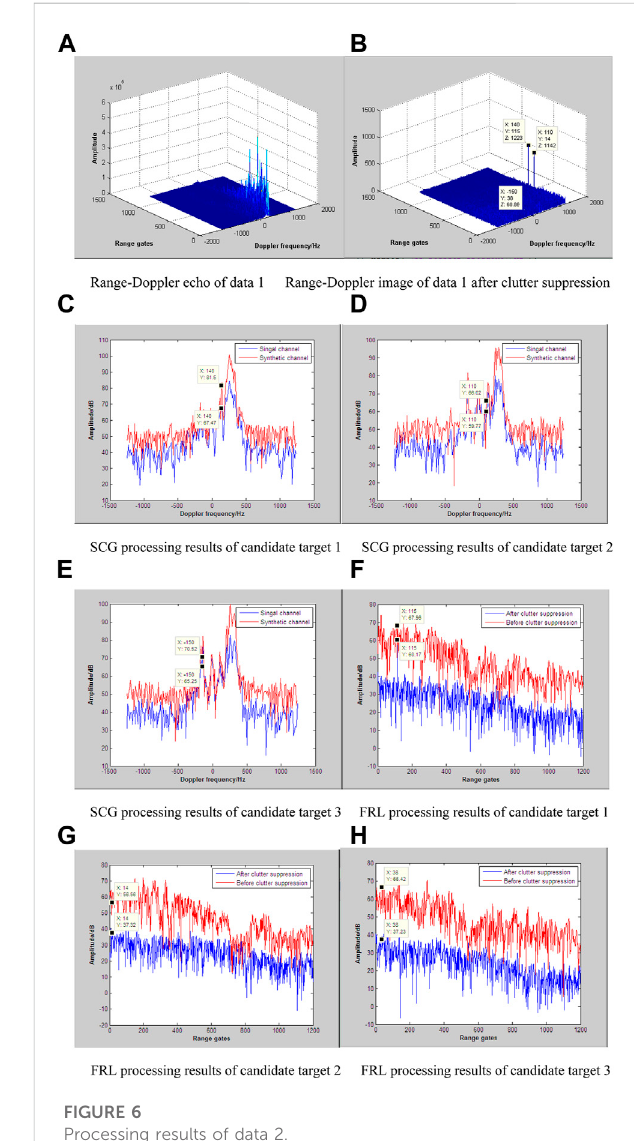
FIGURE 6 Processing results of data